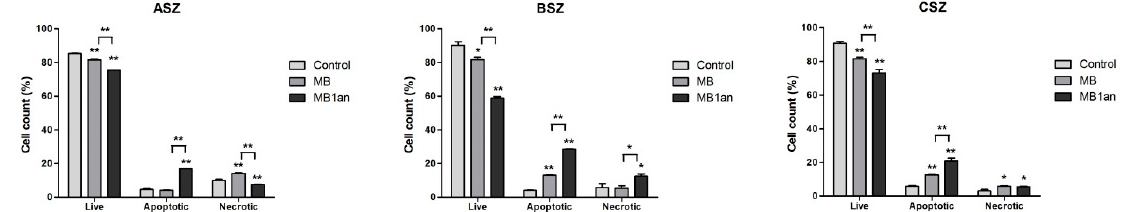
Figure 5. The percentage of live, apoptotic and necrotic cells in ASZ, BSZ, and CSZ cell lines after the irradiation with MB and MB-1an. * p < 0.05, ** p < 0.001.